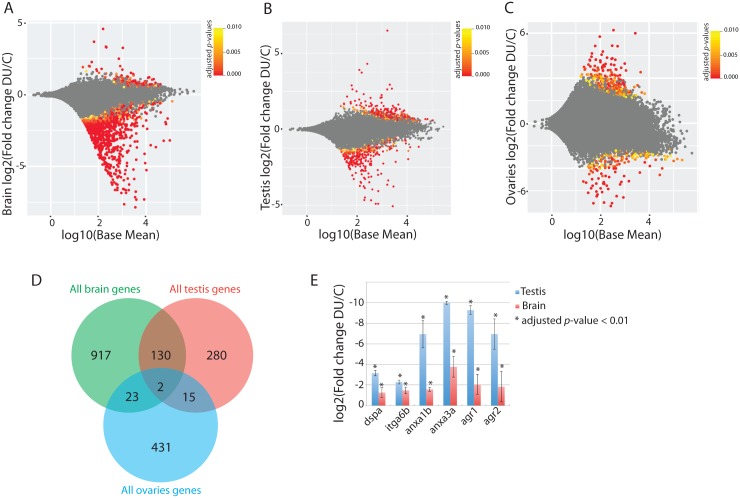
Differential gene expression analysis in the adult tissues following a 10 days chronic exposure to DU.(A-C) MA-plot for the differential analysis in the adult brain (A), testis (B) and ovaries (C). Expression for each gene is shown on the x-axis as the log10 of the mean normalized expression, and the log2 of the fold change on y-axis. Significant adjusted p-values (FDR) < = 0.01 are highlighted in yellow to red, and non-significant changes in grey. (D) Venn diagram of genes mis-regulated in the brain, testis and ovaries. All genes significantly regulated (up- or down- regulated) were used to compare the three tissues. (E) Fold change of genes involved in regeneration and cell adhesion in DU exposed brain and testis compared to controls (all adjusted p-values (FDR) < 0.01; error-bars represent the standard deviation to the mean).